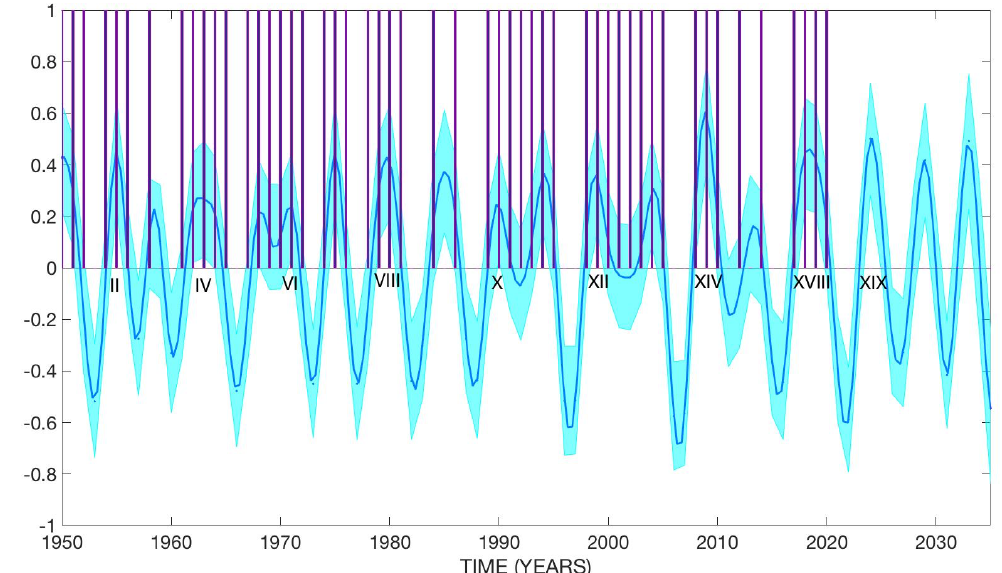
Figure 8. Probabilistic hindcasts and forecasts for the category 2 Atlantic hurricane. Bayesian inference of the LS-SVM model (blue line and shade) compared with the historical category 2 Atlantic hurricanes (purple vertical bars) clustered in 18 groups (I–XVIII). In addition, the probabilistic earthquake prediction is shown for the following period (cluster XIX). The blue shaded area represents the 95% confidence intervals of the Bayesian